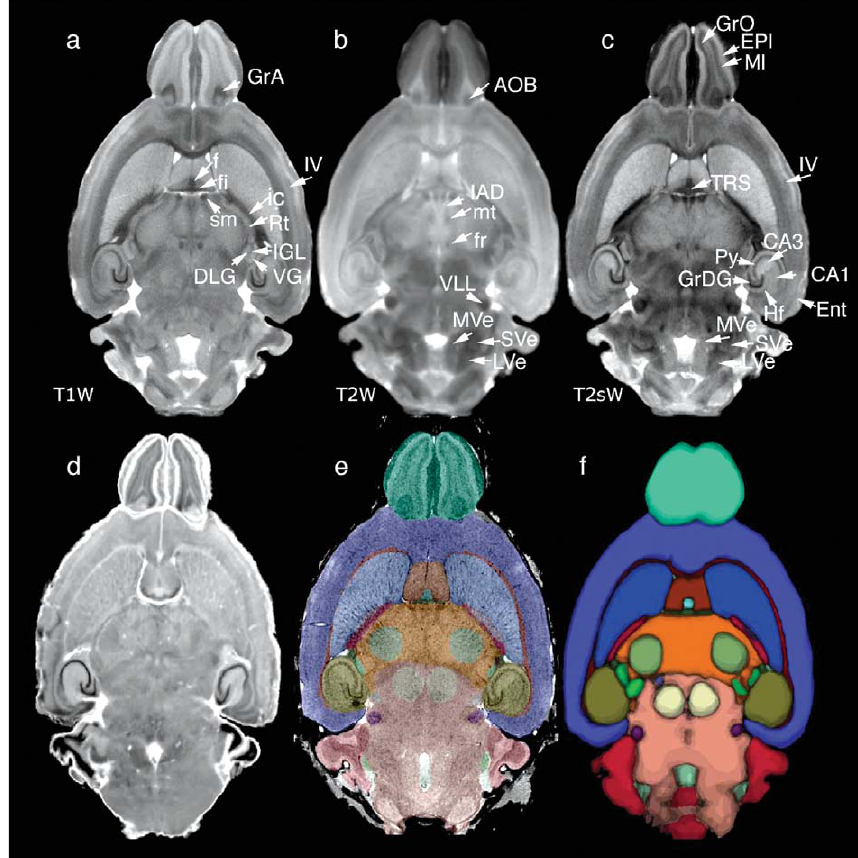
Fig. 12. Multiple specimens imaged with MRM have been used to generate population-averages: (a) T 1 -weighted (T 1 W), (b) T 2 -weighted (T 2 W), and (c) T 2 *-weighted (T 2 s); (d) also a 3D volume of Nissl histology was acquired on one of the specimens; (e) labels defined on the one specimen atlas images can be used to map other mouse brains; (f) labels from multiple specimens have been used to produce a probabilistic atlas that gives insight into volume and shape variability. Modified and reproduced with permission from